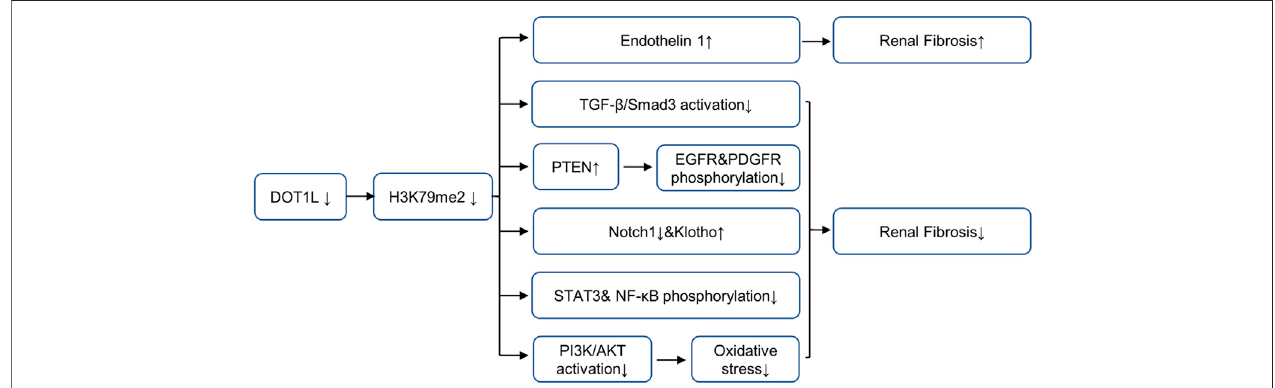
FIGURE 2 | Role and mechanism of DOT1L inhibition in renal fi brosis. Inhibition of DOT1L promotes renal fi brosis by up-regulating ET1. In contrast, Inhibition of DOT1L alleviates renal fi brosis by inhibiting multiple fi brosis pathways (including Smad3, EGFR, PDGFR and NF- κ B pathway), up-regulating the expressions of renal protective factors such as PTEN, Klotho and Smad7,2, and preventing the generation of ROS via the PI3K/Akt pathway. AbbreviationsDOT1L, disruptor of telomeric silencing1-likeprotein;EGFR,epidermalgrowthfactorreceptor;PDGFR,platelet-derivedgrowthfactorreceptor;NF- κ B,nuclearfactor- κ B;PTEN,tensinhomolog deleted on chromosome 10; STAT3, signal transducer and activator of transcription 3; ET1, endothelin